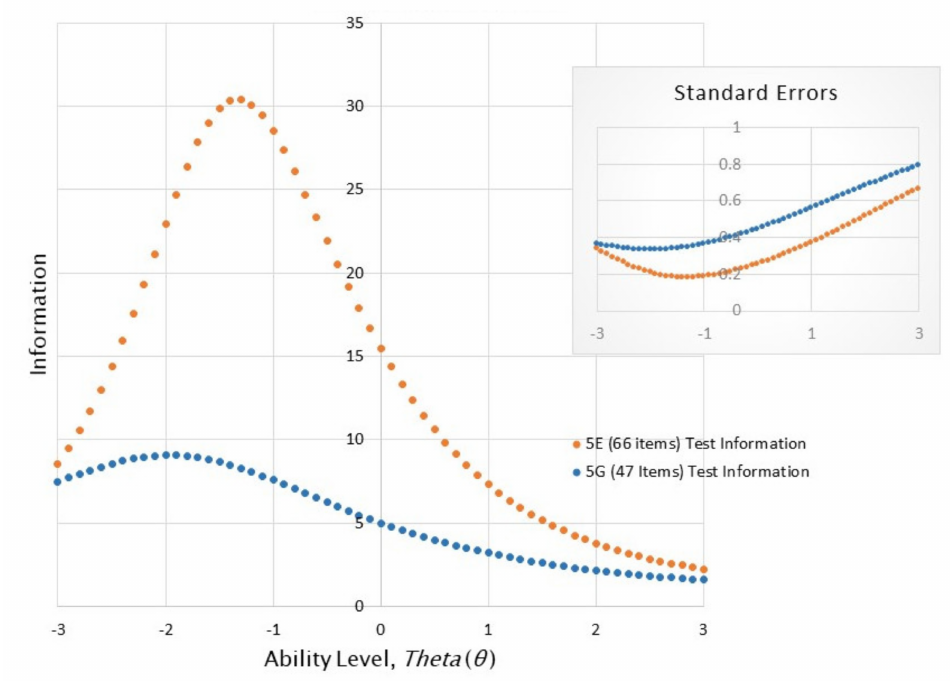
Figure 1. The test information curves and standard errors for the TOPI 5E and